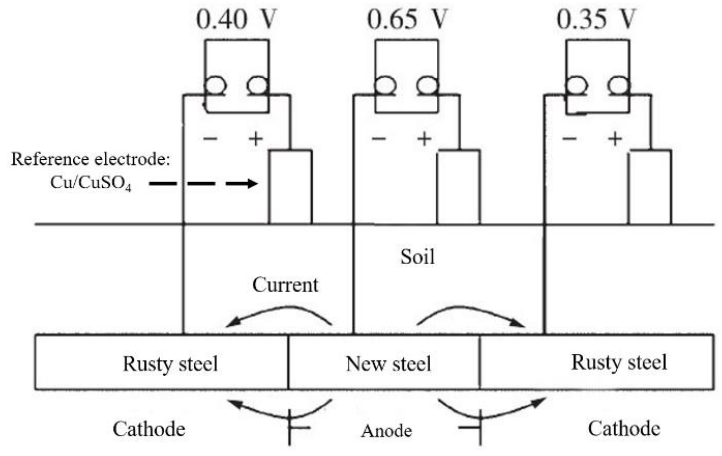
Figure 4. Galvanic corrosion cell formed by contact of new and rusty grounding steels.